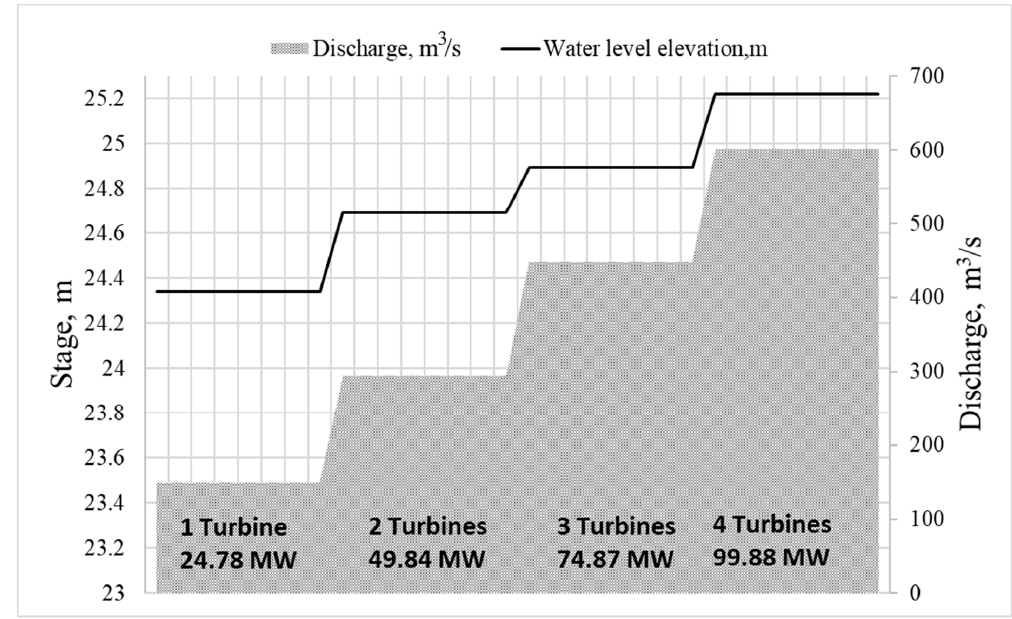
Figure 6. Typical operating regimes of Kaunas hydropower plant and corresponding tailwater levels.